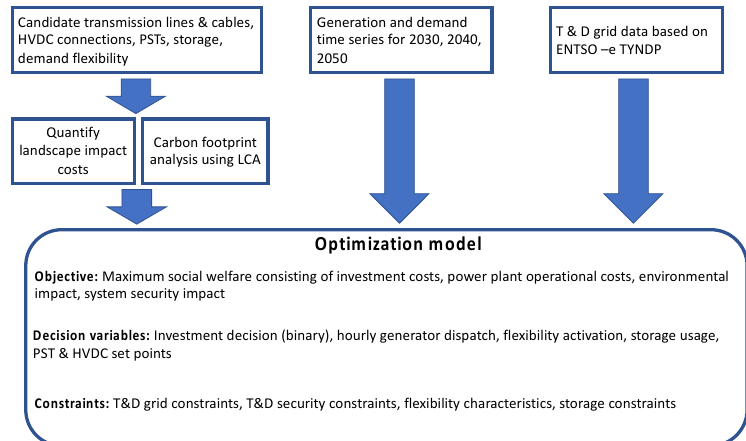
Figure 1 . Building blocks, input parameters and output parameters of the planning tool. Figure 1. Building blocks, input parameters and output parameters of the planning